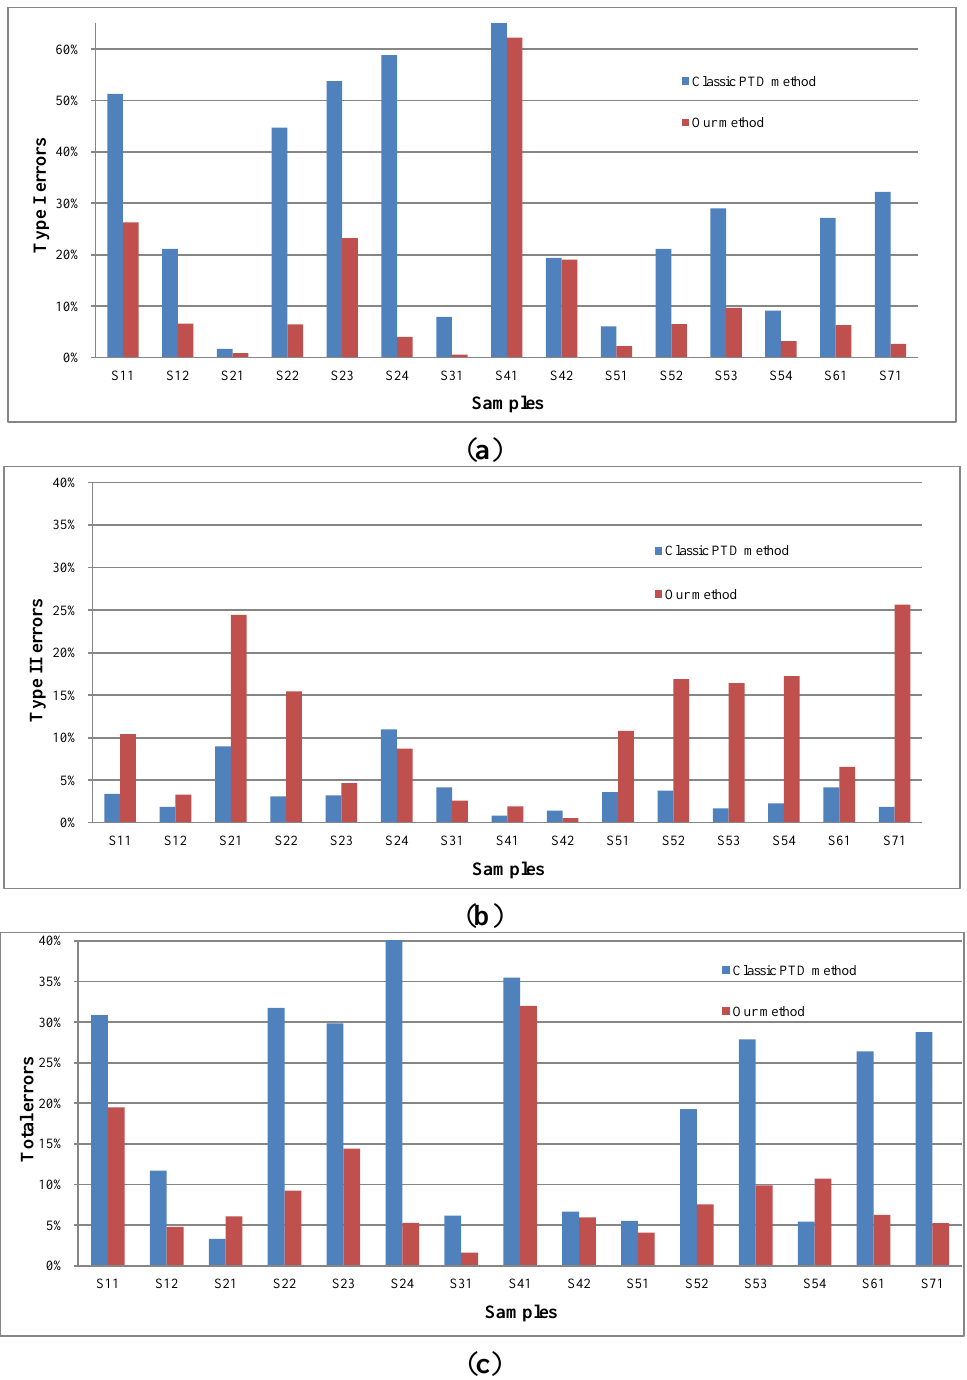
Figure 13. Comparison of the three types of errors for the two methods: ( a ) Type I errors of different algorithms for the samples; ( b ) Type II errors of different algorithms for the samples; ( c ) Total errors of the two algorithms for the samples. Note “S” is abbreviation of “Sample” for the horizontal